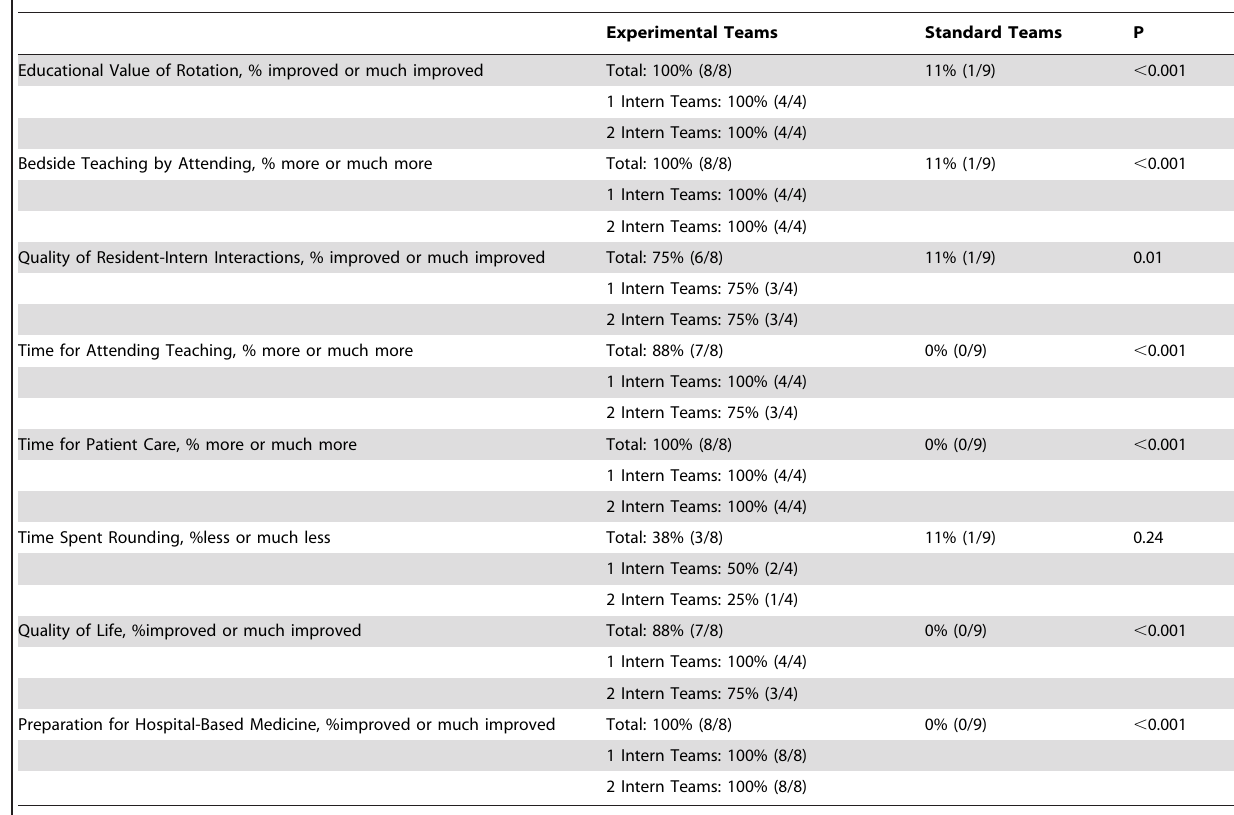
Table 5. Attending Likert Satisfaction Survey*.